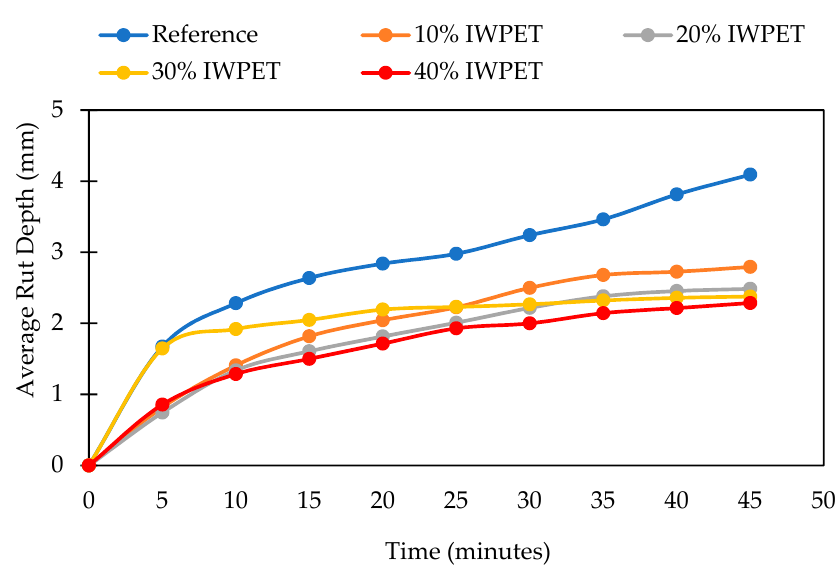
Figure 8. Average rut depth for IWPET modified mixtures at 45 °C.